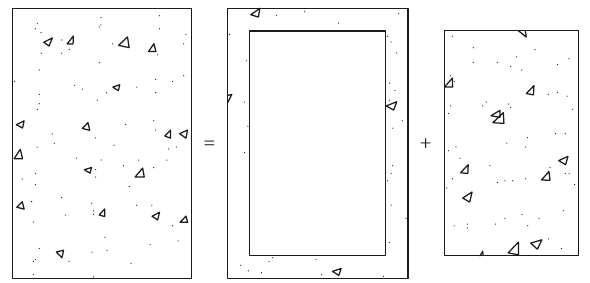
Figure 7: Finite element analysis of concrete